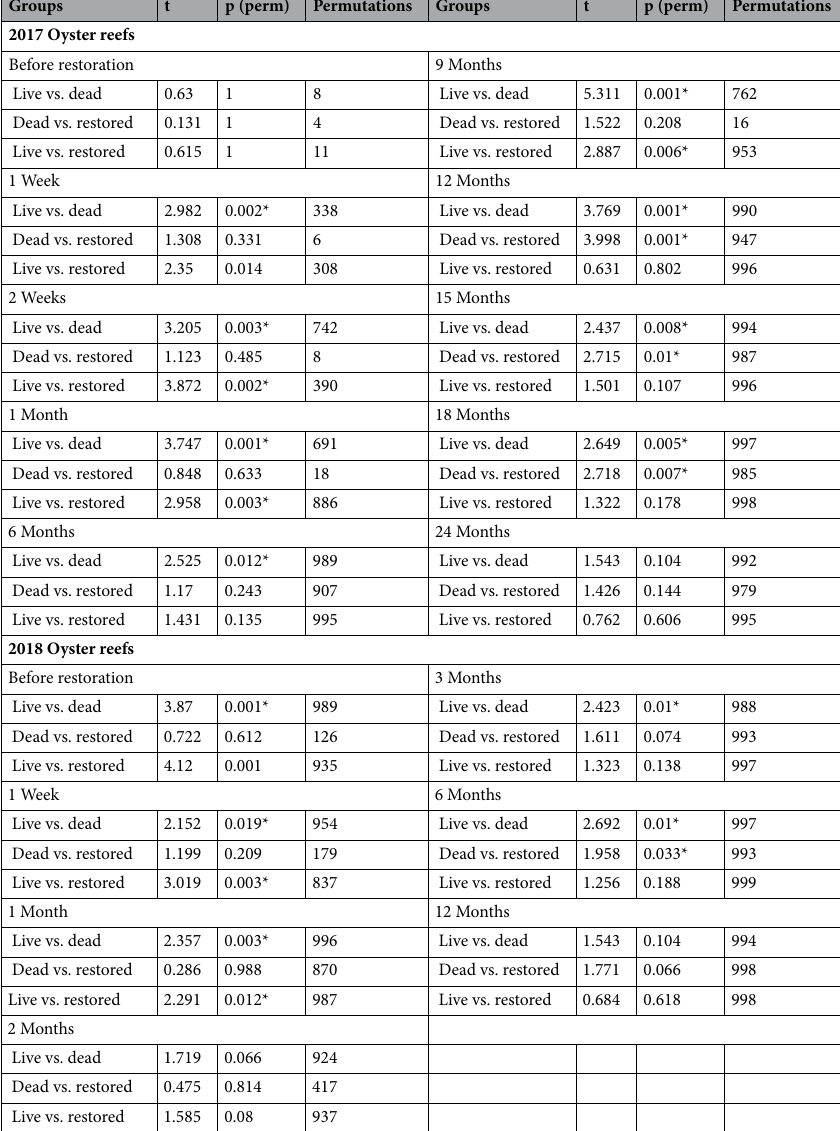
Table 2. Results of PERMANOVA pairwise comparisons of treatments within sampling times. Restored reefs were statistically similar to dead reefs prior to 12 months in 2017. Species composition then shifted approximately 12 months after restoration and became statistically similar to live reefs. Species composition in 2018 shifted from a dead-like state to a live-like state within 6 months of